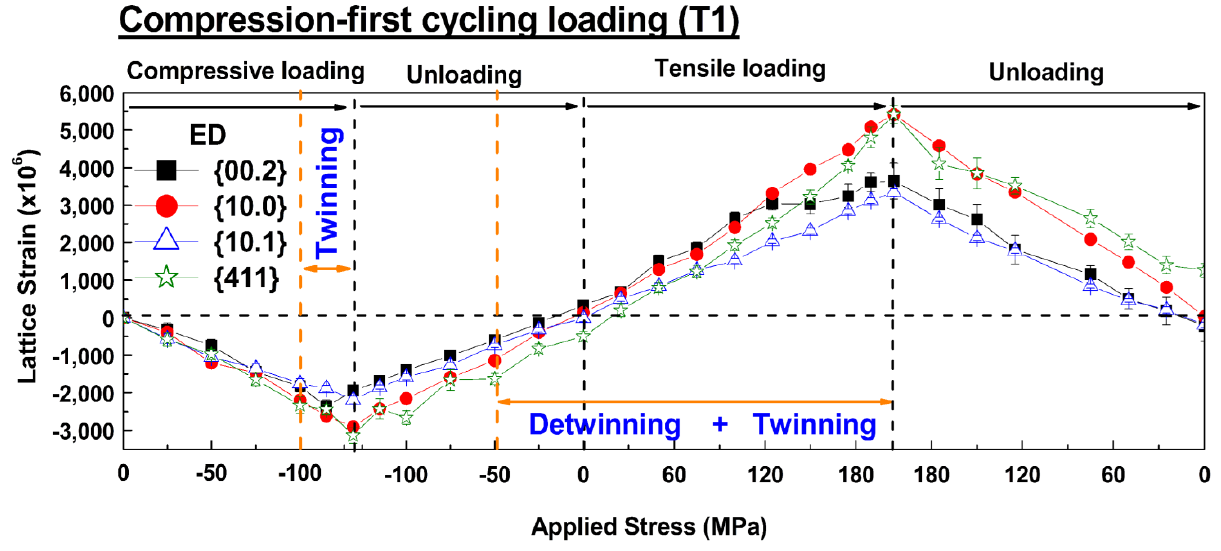
Figure 3. Lattice strain evolution for various grain families as a function of applied stress during the deformation shown in Figure 2. The { hk.l } plane normal is parallel to the applied loading direction, which is parallel to the extrusion direction (ED). The angles between the c-axis and the loading direction for the {00.2}, {10.0} and {10.1} families are 0°, 90° and 61.9°,